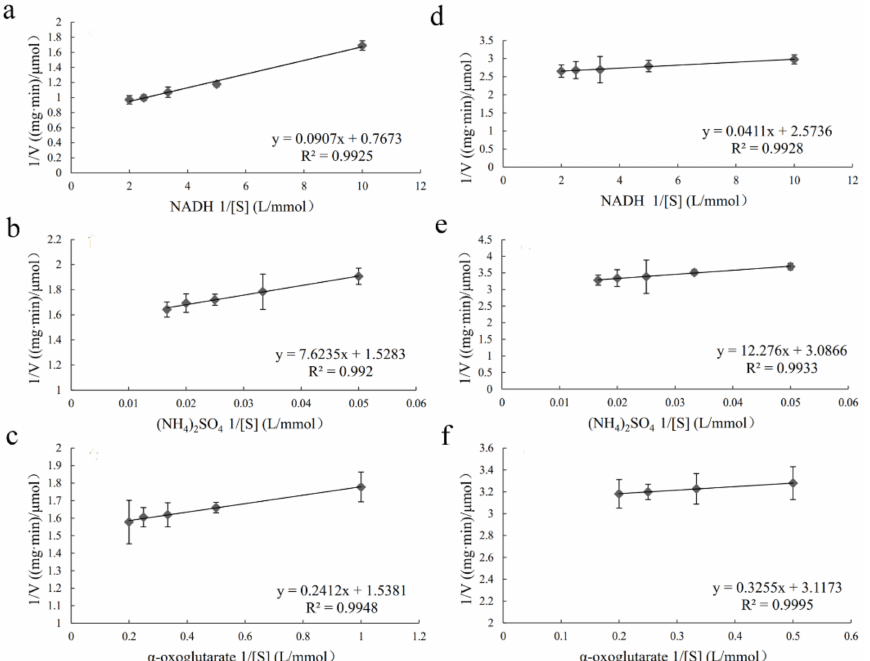
Figure 6. Kinetic analysis of PhGDH1 and PhGDH2. The K m values of PhGDH1 for the substrates of NADH ( a ), (NH 4 ) 2 SO 4 ( b ), and α -oxoglutarate ( c ). The K m values of PhGDH2 for the substrates of NADH ( d ), (NH 4 ) 2 SO 4 ( e ), and α -oxoglutarate ( f ).